Question: Describe this figure in one sentence.
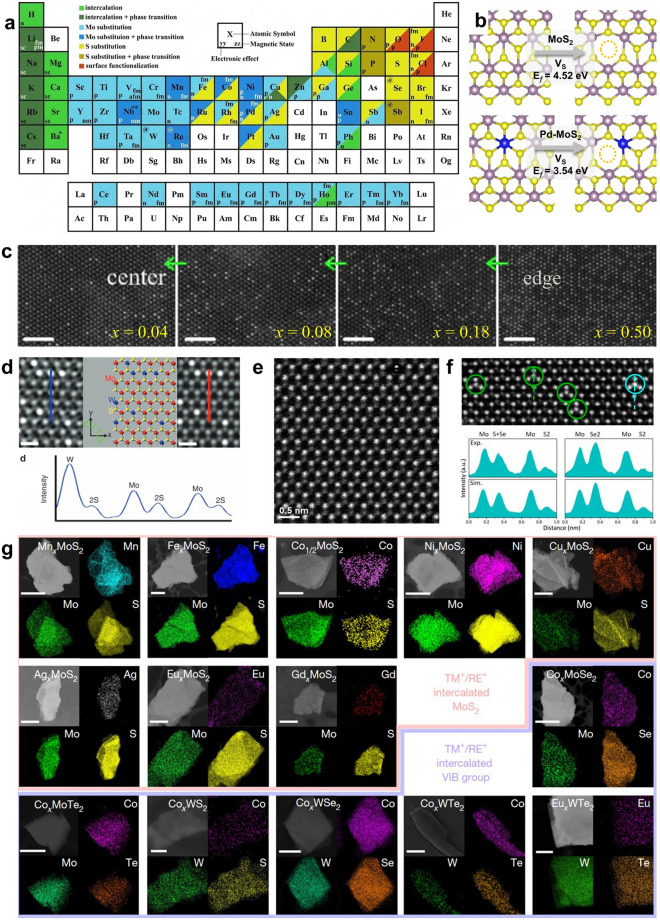
Answer: a Dopant positioning preferences across 2H-MoS 2 frameworks driving coupled transformations in phase structure, electronic states, and magnetic configurations [ 102 ]. Copyright 2022 Elsevier. b Comparison of the relaxed atomic structures and formation energies of S vacancies in pristine MoS 2 and Pd-doped MoS 2 [ 98 ]. Copyright 2018 Springer Nature. c HAADF-STEM images of Mo 1− x W x S 2 alloy, from the Mo-rich configuration to W-rich configuration [ 115 ]. Copyright 2019 American Chemical Society. d Atomic-level Mo 1− x W x S 2 configuration and the corresponding simulated HAADF-STEM images (right) and measured HAADF-STEM images (left), and the intensity distribution along the marked path (bottom) [ 116 ]. Copyright 2013 Springer Nature. e Atomic-level HAADF-STEM image of MoS 2 and f MoS 2(1− x ) Se 2 x (top) and the corresponding intensity distribution along the marked path (bottom) [ 117 ]. Copyright 2014 American Chemical Society. g Cation exchange strategy for universal intercalation of TMDs [ 118 ]. Copyright 2025 Springer Nature